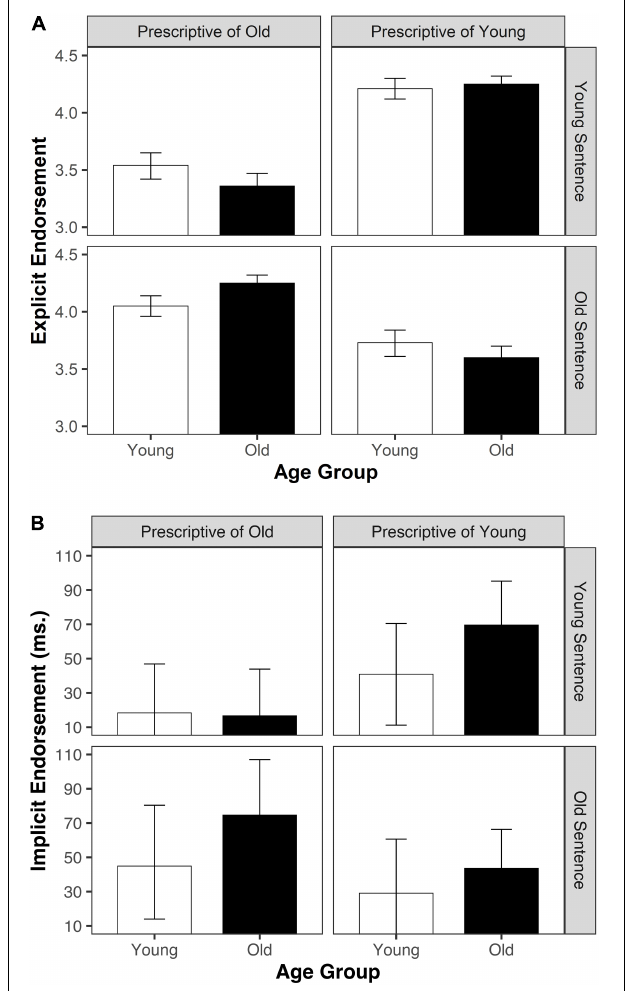
FIGURE 2 | Explicit (A) and Implicit (B) Endorsement of Matching (1st and 3rd quadrants) and Mismatching (2nd and 4th quadrants) Sentences by Age Group, whiskers denote ± 1